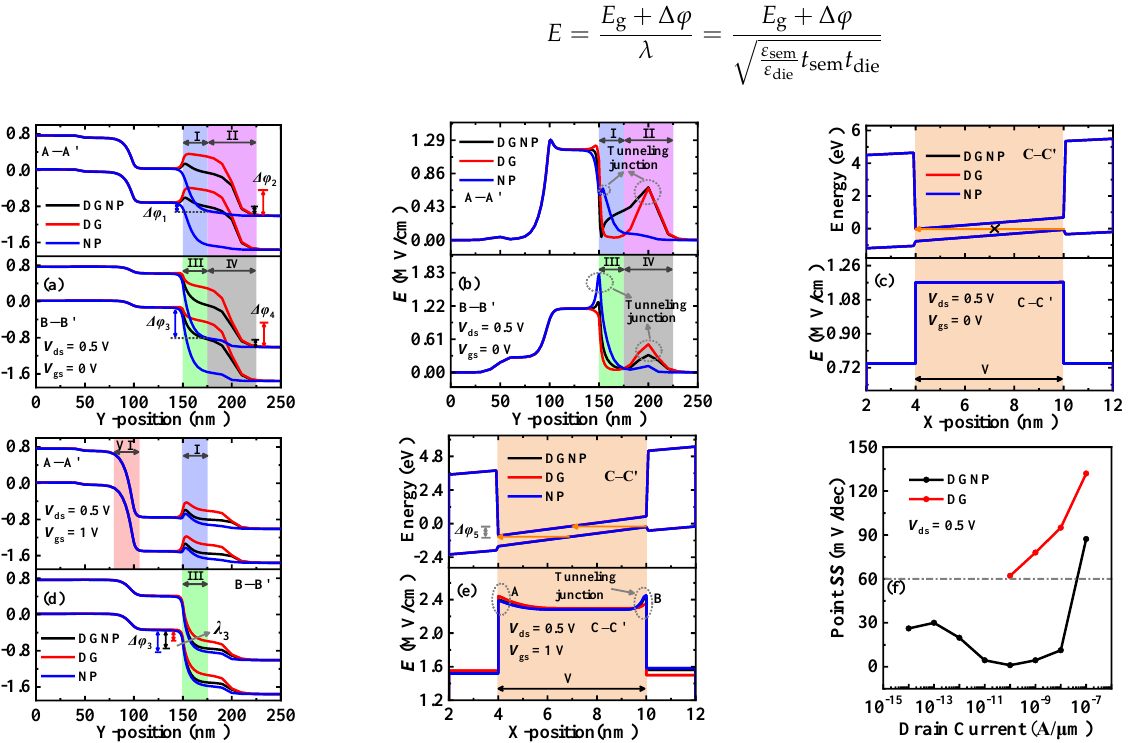
Figure 5. ( a ) Energy band profiles along A –A’ and B–B’ in the OFF -state; ( b ) electric field profiles along A –A’ and B–B’ in the OFF -state; ( c ) energy band and electric field profiles along C –C’ in the OFF-state; ( d ) energy band profiles along A–A’ and B–B’ in the ON-state; ( e ) energy band and electric field profiles along C –C’ in the ON -state; and ( f ) point SS versus drain current for EHBTFETs. To investigate I ON , the energy band profiles in the ON-state are calculated and shown in Figure 5d. It is seen that PT occurs in regions III and VI simultaneously because the applied V gs bends down the energy bands in both regions. Due to the existence of CG, the energy bands of DG-EHBTFET are lifted obviously in regions I and III. The elevated en- ergy band in region I hinders the tunneling electrons drifting to the drain, while that in region III reduces Δφ 3 and increases λ 3 so as to directly weaken the carrier tunneling, both of which lead to a reduction in the I ON of DG-EHBTFET. Since the introduction of the N + - pocket can lower the energy bands in regions I and III, a high I ON can be maintained in DGNP-EHBTFET like in NP-EHBTFET. In the ON-state, the existence of Δφ (see Δφ 5 in Figure 5e) enhances the E of LT, which is consistent with the result in Equation (2). How- ever , unlike E in the OFF-state, E in regions A and B (see dotted circles in Figure 5e) in the ON-state further increases. This is because PT also affects the E of LT in the gate overlap region. It is observed from Figure 5d that the raised energy band in region I of DG-EHBT- FET causes a large number of tunneling electrons from region VI to concentrate in the gate overlap region near TG, eventually resulting in the highest E in its region A. However, the existence of the N + -pocket bends the energy band downward in region III for NP-EHBT- FET and DGNP-EHBTFET, which is more conducive to the accumulation of holes in the gate overlap region near RG, leading to a higher presence of E in region B (i.e., tunneling junction) of these two EHBTFETs. The higher the E , the higher the I ON that can be obtained. Therefore, the I ON of three EHBTFETs results in the aforementioned results. The average subthreshold swing ( SS avg ) is obtained using Equation (3) [9,14] SS avg = ( V th − V OFF )/(log I Vth − log I VOFF ), (3) where the subthreshold voltage ( V th ) represents V gs at which the drain current ( I ds ) equals 0.1μA/μm (i.e., I Vth ), V OFF is V gs at which I ds begins to increase with V gs , and I VOFF is the corresponding I ds when V gs = V OFF . It is found from Figure 4 that neither the V th nor SS avg of NP-EHBTFET can be extracted because NP-EHBTFET has been turned on in the OFF- state. Thus, only the values of SS avg and V th for DG-EHBTFET and DGNP-EHBTFET are